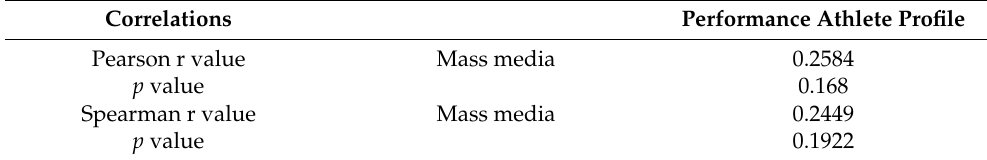
Table 10. Pearson and Spearman correlation for performance athlete